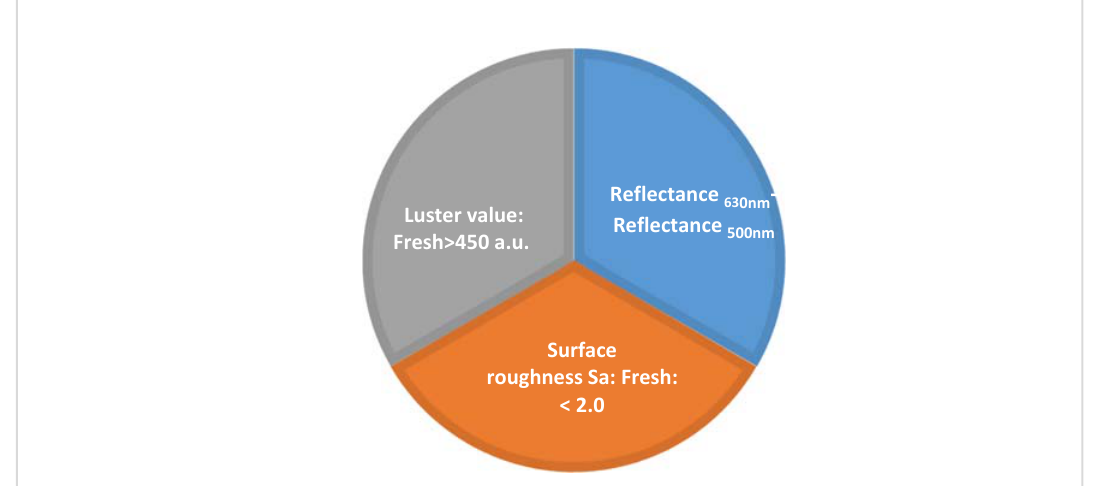
Figure 10. Visualized example for a possible freshness index, integrating the current findings (Figure 6, Figure 9, and Table 2) and two or three parameters depending on available instrumentation and situation (transport, storage, retail); spectral values (Table 2)/thresholds depend on fruit color.